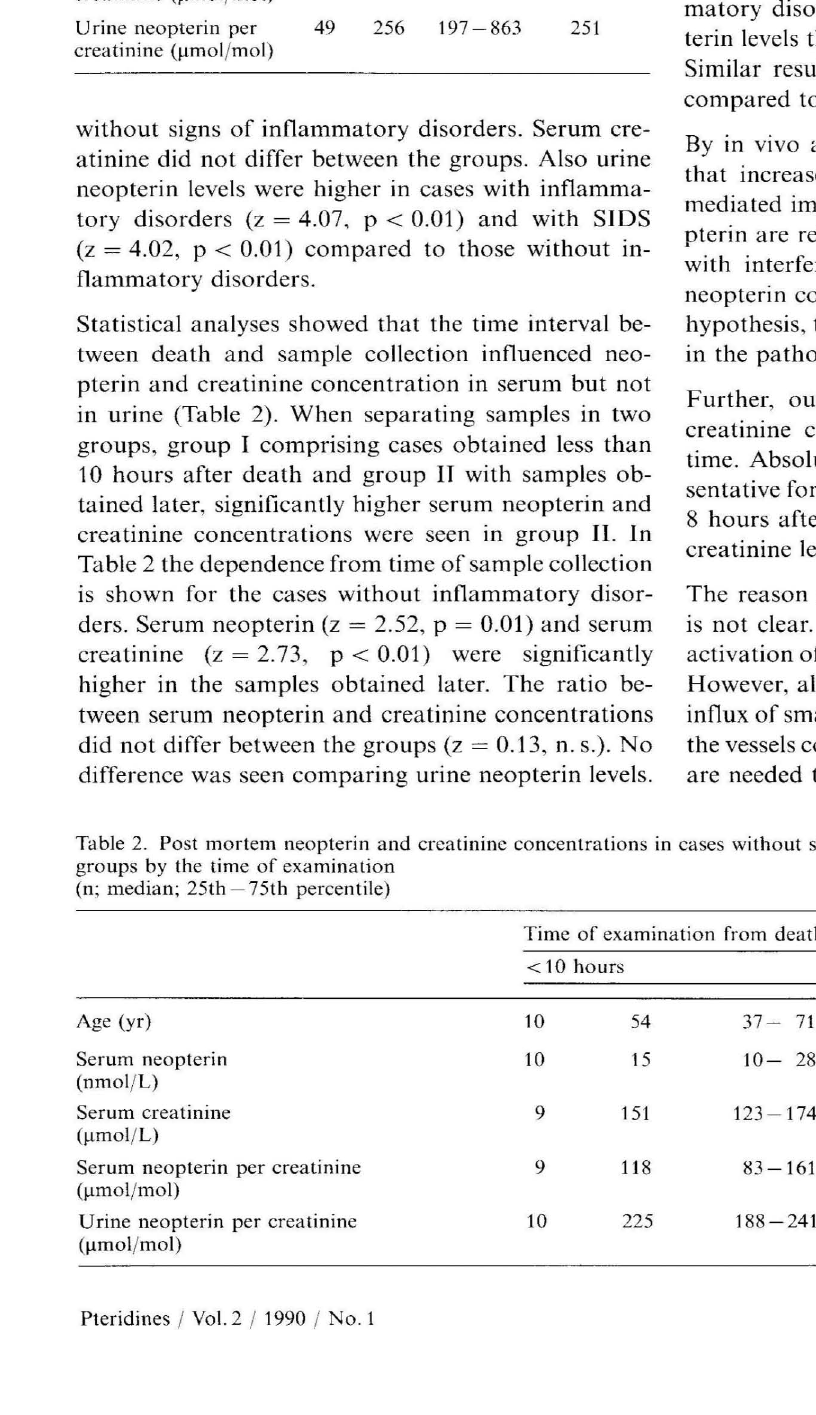
Pteridines / Vol. 2 ! 1990 I No.